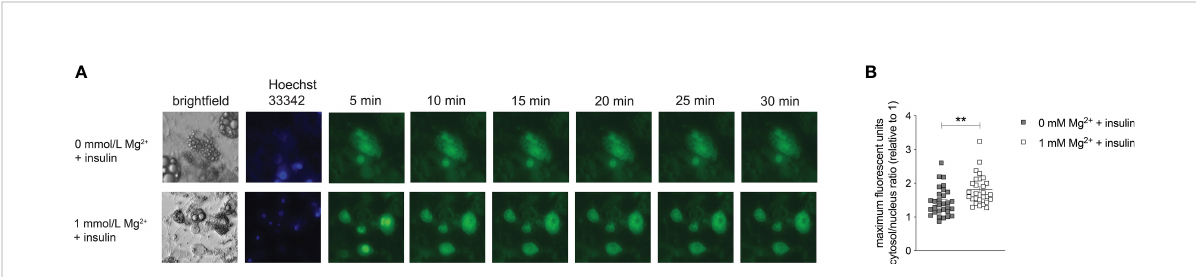
FIGURE 5 Effect of Mg 2+ on insulin-dependent Akt activation. Live imaging of insulin-stimulated 3T3-L1 adipocytes transduced with pLenti-FoxO1-Clover and incubated with 0 or 1 mmol/L Mg 2+ . (A) Live images showing Bright fi eld, Hoechst 33342 and Clover signal in 3T3T-L1 adipocytes stimulated with insulin. (B) Quanti fi ed maximal mean intensity ratio of the cytosol in 3T3-L1 adipocytes stimulated with insulin (n=5, 3 – 10 cells analyzed per biological replicate). Statistically analyzed with Student ’ s T-Test. grey color is 0 mmol/L Mg 2+ and white color is 1 mmol/L Mg 2+ . Mg 2+ , magnesium; min, minutes. **p<0.01.